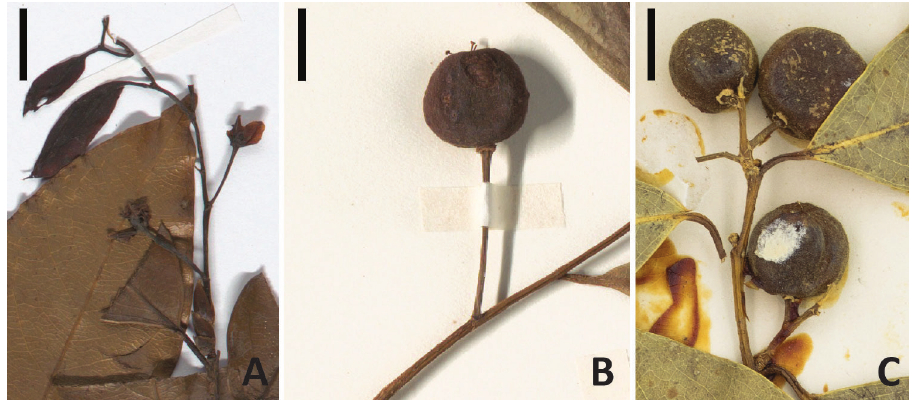
Figure 1. Morphology of the Drypetes indica complex A D. indica (detail of L.2207751), branch tip showing perulate bud below an expanding shoot with proximal flowers and distal leaves B D. indica (detail of L.2207743) fruit with elongate styles bearing flabellate stigmas C D. nienkui (detail of NY02684347, holotype) with two cymose infructescences. Scale bars equal 1 cm. Photos A, B CC 1.0 Naturalis Biodi- versity Center C CC 4.0 New York Botanical